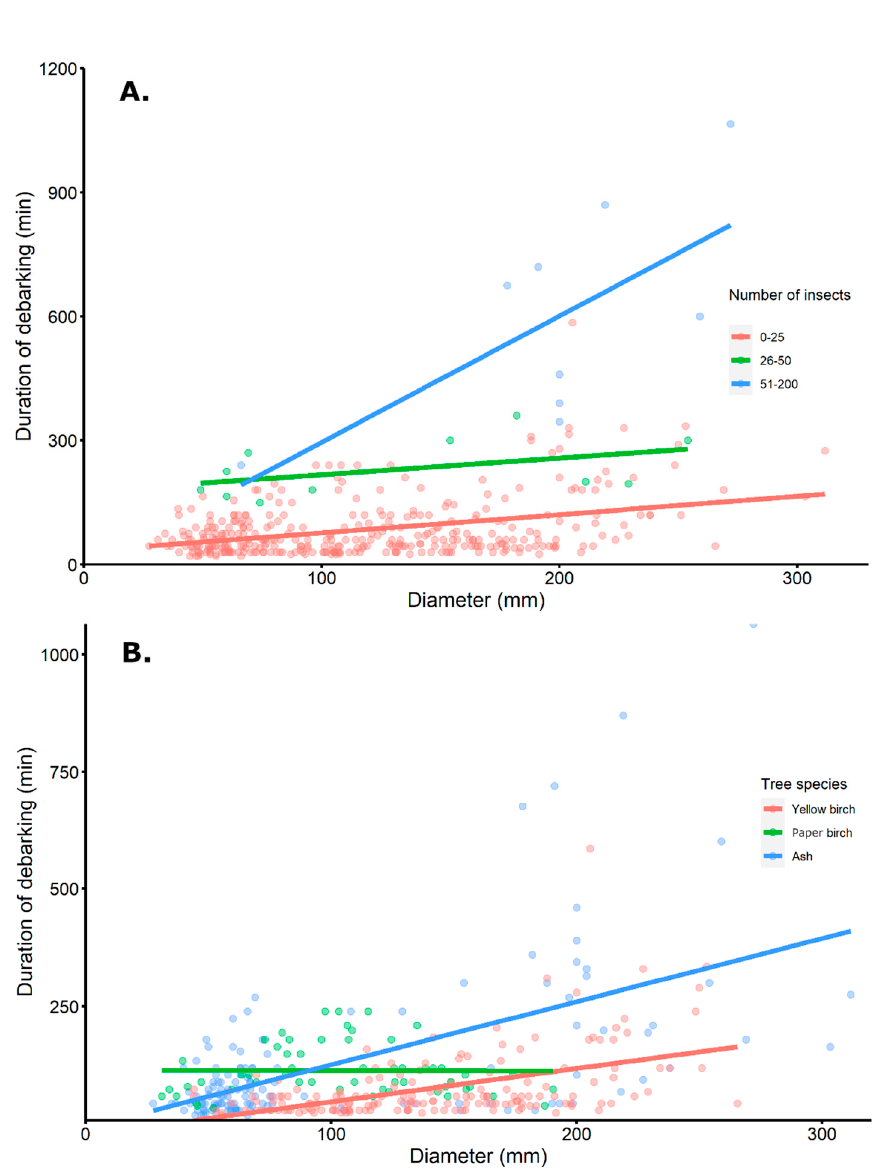
Figure 2. Duration (mean ± SD) of debarking for each Agrilus species depending on the diameter of the sample, the number of insects found ( A ), and the tree species ( B ). the sample, the number of insects found ( A ), and the tree species ( B